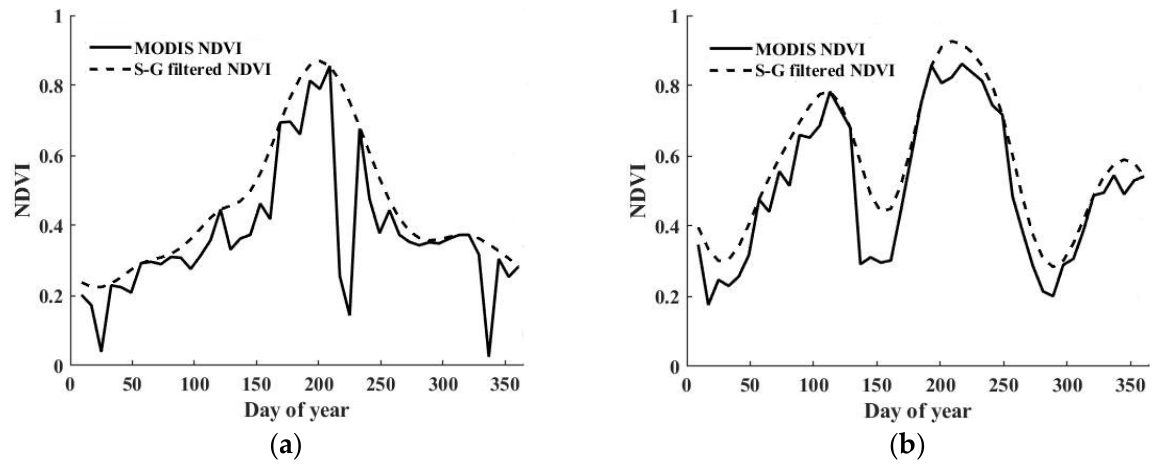
Figure 5. S–G filtered NDVI for (a) single-cropping and (b) double-cropping regions.